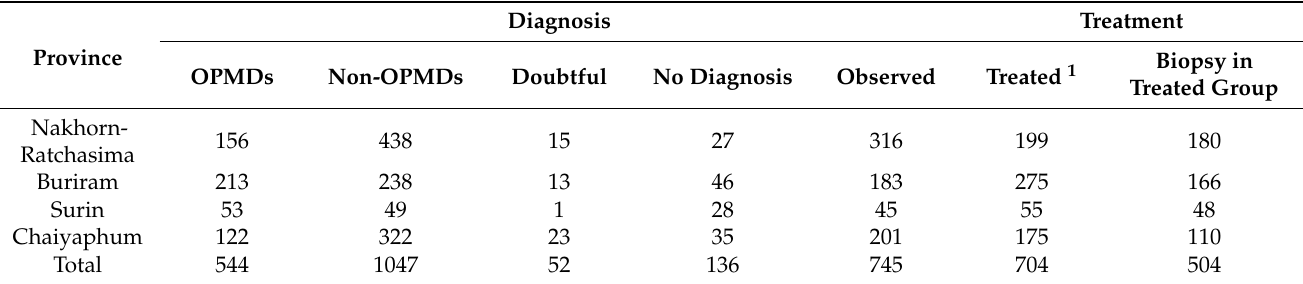
Table 2. Results of individuals diagnosed and treated at the S3 level.